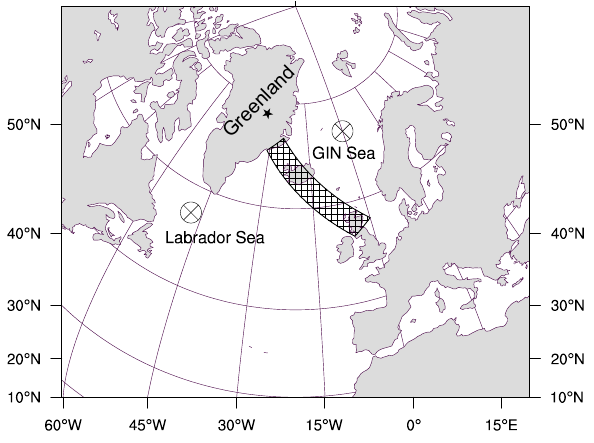
Fig. 1. Partial blocking region in NA (black hatching).